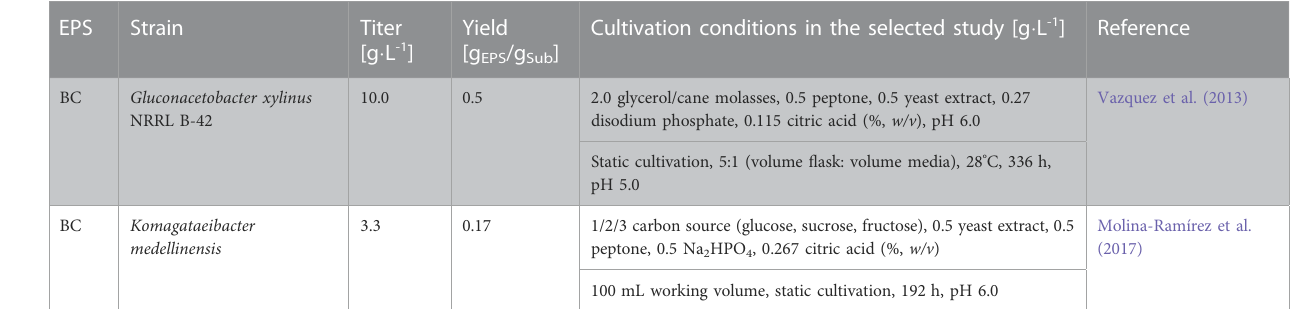
TABLE 1 ( Continued ) Overview of homopolysaccharides producing Acetobacteraceae